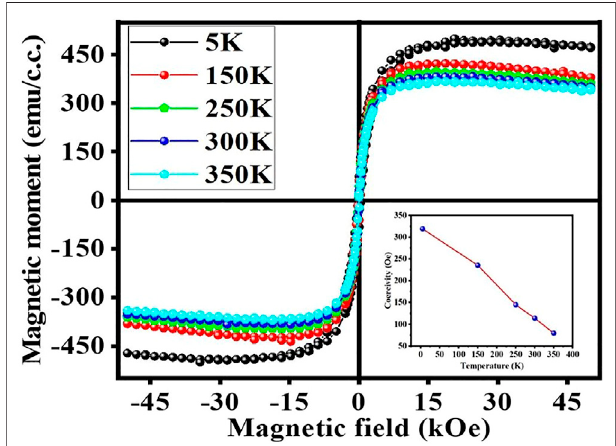
FIGURE 3 | Magnetic fi eld (H)-dependent isothermal (5, 150, 250, 300, and 350 K) magnetization (M) behavior of the NZFO fi lm. The inset shows the variation of coercivity with temperature.